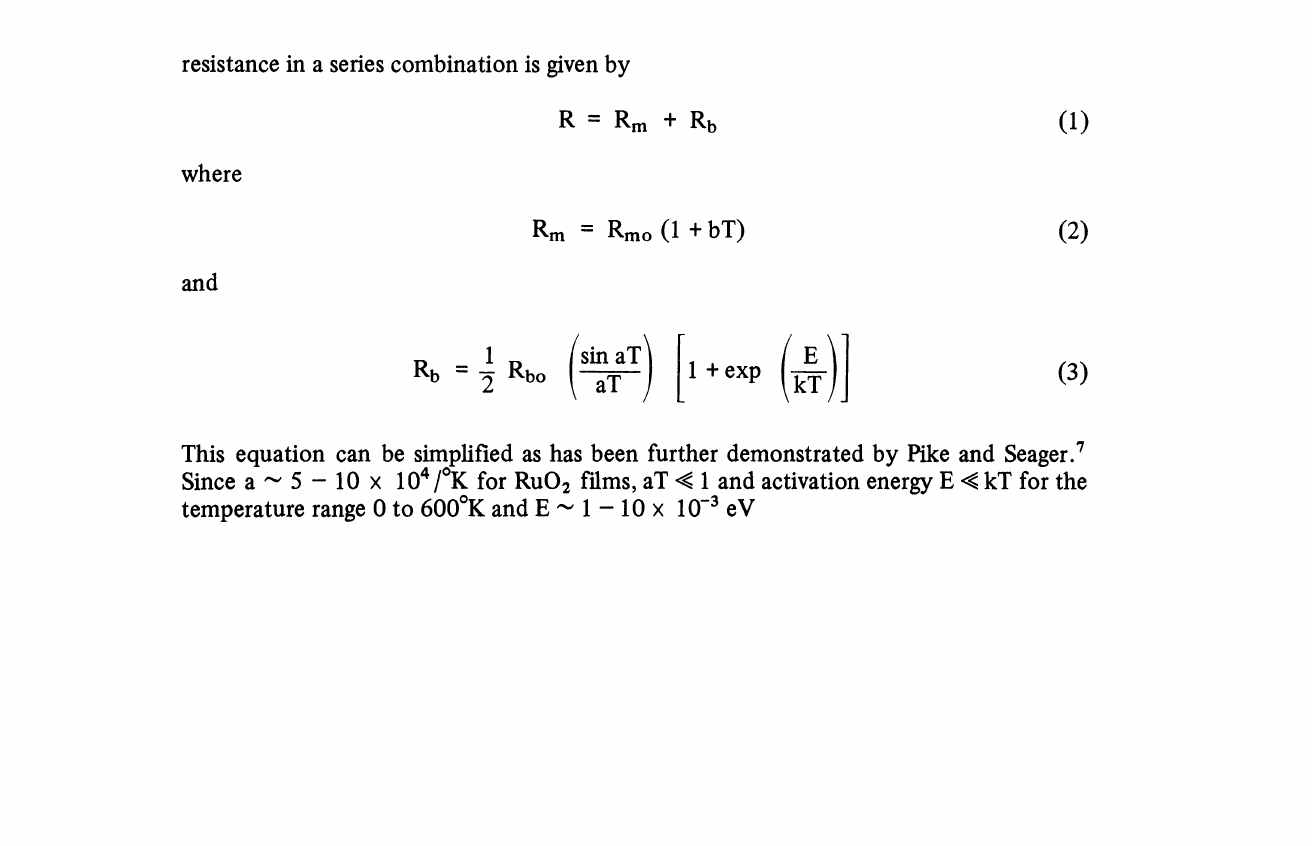
The tunneling mechanism of an electron in a thick film resistor. The resonance-type tun- neling occurs when the width of the barrier is thin, such as the one in extreme left barrier. However, the phonon asisted hopping is possible when the width is wide enough, allowing many electron steps before tunneling out the